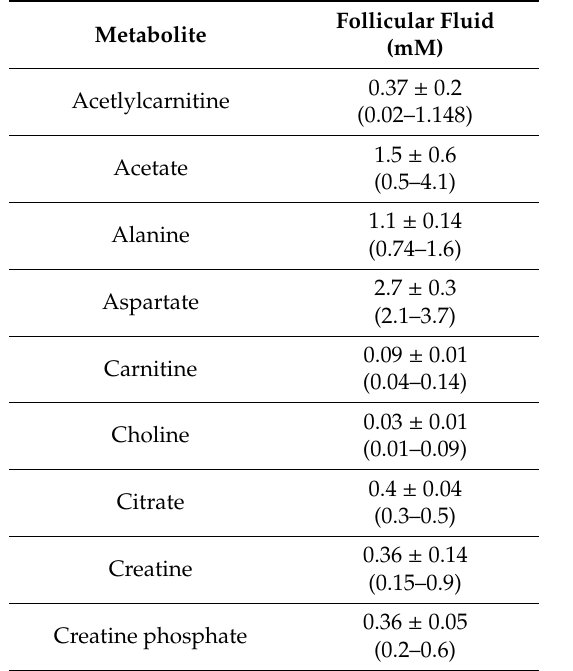
Table 2. Concentrations of metabolites detected in equine preovulatory follicular